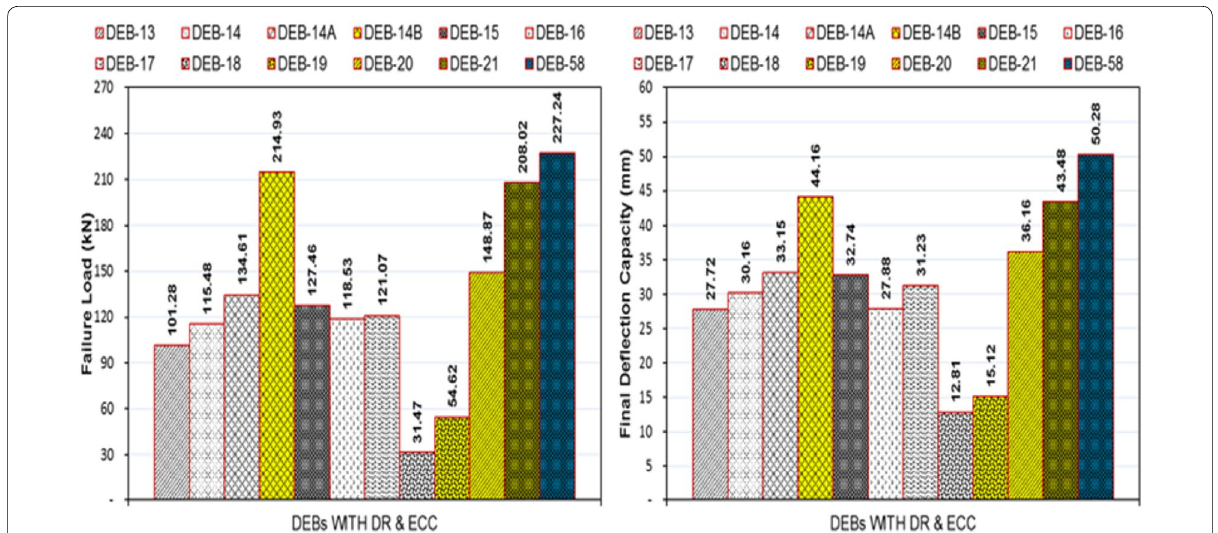
Fig. 14 Failure load and final deflection capacity in the second